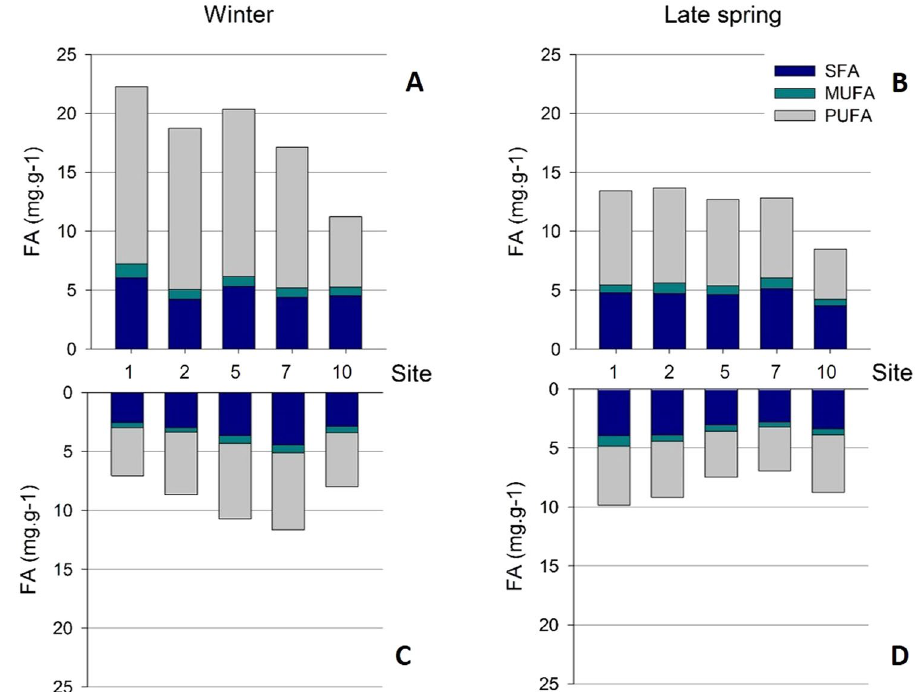
Figure 7. Esterified fatty acid (FA) concentration (mg g − 1 ) in Z . noltei aboveground biomass at sites 1, 2, 5, 7 and 10 at Mira channel; in winter ( A ) and late spring ( B ). Graphs ( C ) and ( D ) show the FA concentration in belowground biomass at the same sites, for winter and late spring, respectively. Saturated fatty acids (SFA),